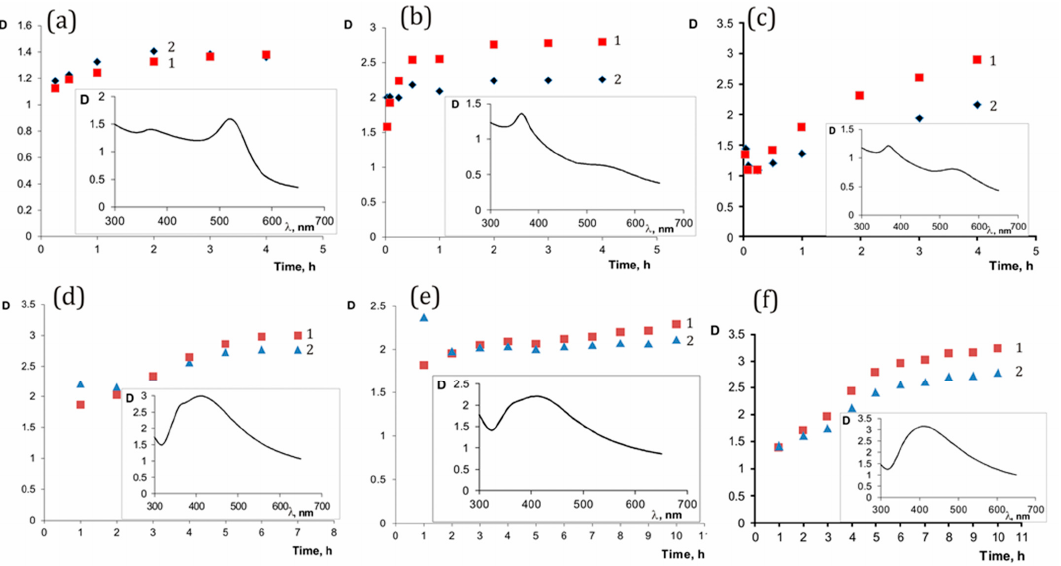
Figure 1. UV-Vis spectra and the kinetics of formation of heterodimers (95 °C, pH 12): VM/Au 0 /ZnO ( a ), EM/Au 0 /ZnO ( b ), SM/Au 0 /ZnO ( c ), VM/Ag 0 /ZnO ( d ), EM/Ag 0 /ZnO ( e ), and SM/Ag 0 /ZnO ( f ). Curves 1—the change in optical density at 406 or 520 nm for plasmon resonance nanoparticles Ag 0 or Au 0 , respectively; curves 2—the change in optical density at 370 nm for zinc oxide during the reaction. Inset: the UV-Vis spectra of the fi nal products of the reactions. The ZnO/Au 0 and ZnO/Ag 0 nanocomposites exhibit strong absorption in the visible region as shown in Figure 1. The absorption wavelength or broad band around 365–375 nm was the speci fi c peak of ZnO, absorption peaks at 520 nm and band at 406 nm were a tt ributed to the Au 0 and Ag 0 nanoparticles, respectively [64–66]. At the initial moment of the reaction, turbidity was observed in the system, apparently due to the formation of zinc hydroxide (zinc hydroxide polymer derivatives). Then, during the reaction, the system becomes more transparent and acquires a color characteristic of gold or silver nanoparti- cles caused by their surface plasmon resonance. At the same time, the absorption band characteristic of zinc oxide also increased, and changed almost synchronously with the change in the absorption band of the nanometal, except for the initial period of time (Fig- ure 1a–f). The obtained dilute solutions of heterodimers are shown in Figure S1 (Supple- mentary Materials). In the presence of gold and zinc cations and a VM stabilizer copoly- mer under the selected conditions, the reaction was almost completed in 2 h, for SM and EM it took about 3–4 h (Figure 1a–c), while the characteristic absorption bands of the fi nal products were fi nally formed and their intensity practically did not change. In the pres- ence of gold and zinc cations and the copolymer-stabilizer VM under the selected condi- tions, the reaction was practically completed after 2 h, for SM and EM it took about 3–4 h (Figure 1a–c), while the characteristic absorption bands of the fi nal products were fi nally formed and their intensity practically did not change. The test for the presence of residual noble metal ions at the end of the reaction was carried out for gold ions. For this purpose, we investigated the changes in the absorbance of silver nanoparticles during the galvanic oxidation of these nanoparticles with perhaps present gold cations from our samples [55,67]. In this case, the working solution was a copolymer of ethylene with maleic acid